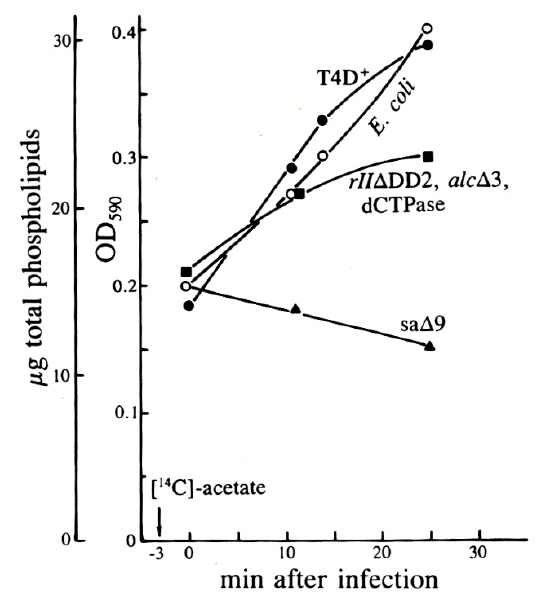
Figure 10. Total phospholipid levels after T4 infection of E. coli in exponential phase, as determined by the Victoria Blue R method of Eryomin and Poznyakov [32]. Uninfected cells are compared with cells infected with T4D, its mutant sa ∆ 9, or the triple mutant ( rII ∆ DD2, alc ∆ 3, am dCTPase ); the rII ∆ DD2 deletion partly overlaps sa ∆ 9, as seen in Figure 1. Neither the dCTPase amber mutant nor the deletion in the pseT/alc region (see Figure 1) made any difference. Reproduced from [31].